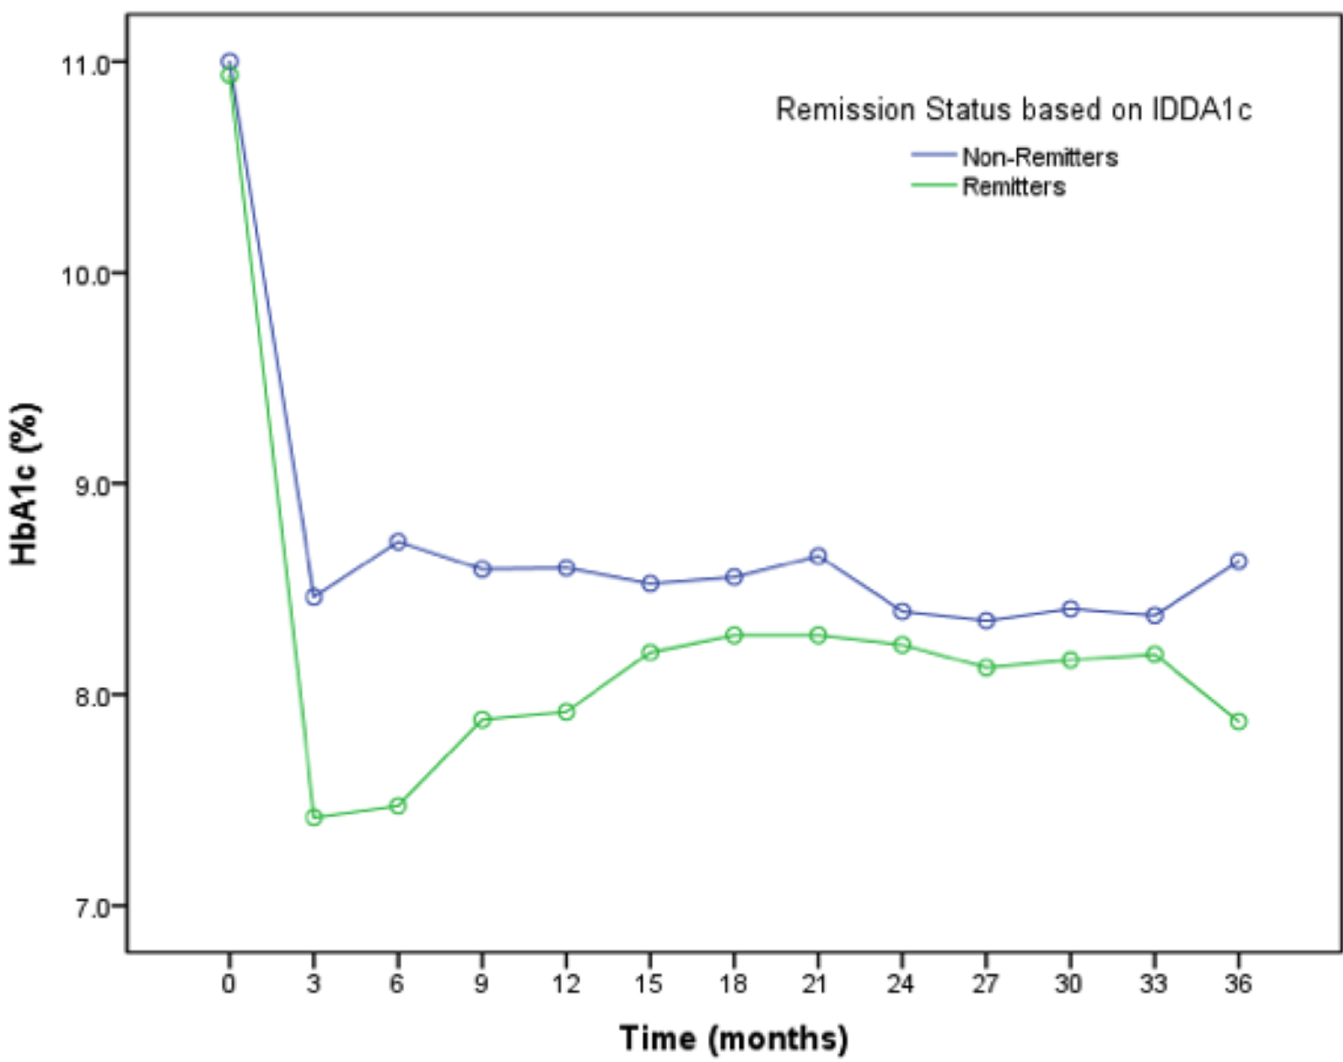
Fig 2. Graphical representation of the pattern of hemoglobin A1c trends in remittersand non-remitters in the first 36 months following the diagnosis of type 1 diabetes. Remission was definedby an insulin-dose adjusted hemoglobin A1c level of (cid:20) 9[23]. Mean HbA1c was similar at diagnosis betweenthe remitters and non-remitters 11.4 ± 2.4 vs. 11.5 ± 2.1, p = 0.584, then became significantly lower in the remitters from 3 months, 7.5 ± 1.0 vs. 8.6 ± 1.3, p < 0.001, through 18 months, 8.2 ± 1.1 vs 8.7 ± 1.2, p = 0.008, and was non-significantly lower in the remitters thereafter.